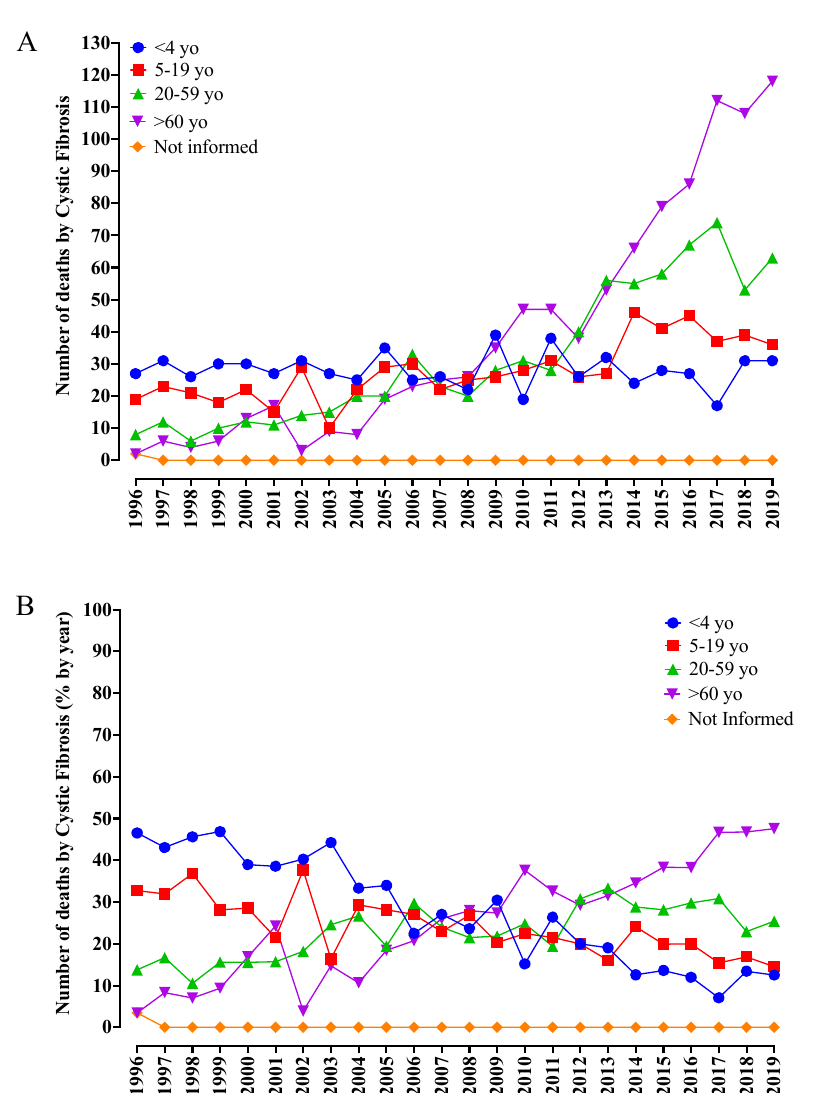
Figure 2. Number of deaths from cystic fibrosis (CF) in Brazil from 1996 to 2019 according to age group (Figure 2A) and relative percentage of deaths (Figure 2B). ( A ) The <4-year-old age group presented 27 cases in 1996 and 31 cases in 2019, resulting in 674 (22.1%) deaths from CF in the period analyzed. The age group from five to 19 years old presented 19 deaths in 1996 and 36 deaths in 2019, totaling 667 (21.9%) deaths from CF. The age group from 20 to 59 years old resulted in eight cases in 1996 and 63 deaths in 2019, resulting in 757 (24.8%) occurrences. Finally, the >60-year-old age group had two cases in 1996 and 118 cases in 2019, totaling 950 (31.2%) deaths from CF during the study period. ( B ) Considering all the age groups presented in the study, the >60-year-old age group showed steady growth over the years. Such a result suggests that CF management has contributed to longer life expectancy. yo, years old; %, percentage.